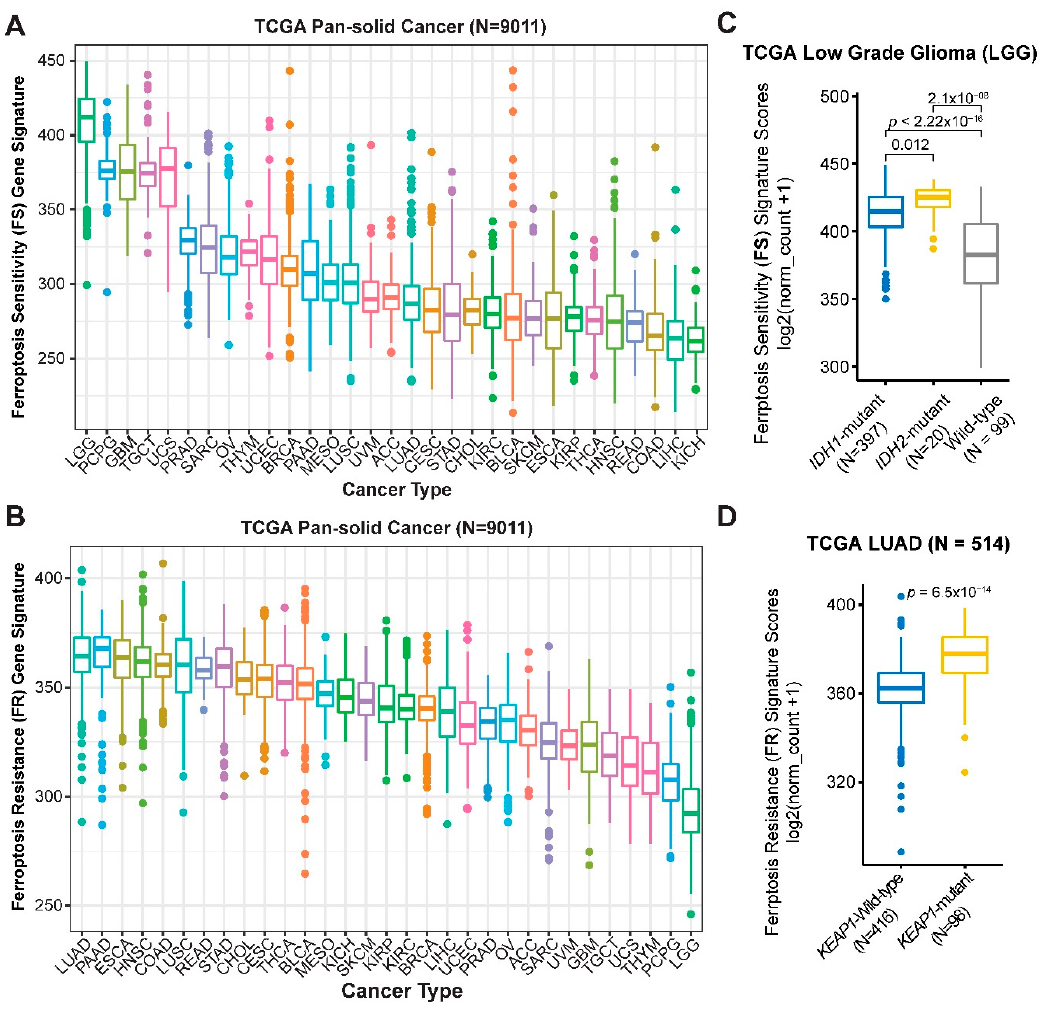
Figure 4. Generalized gene signatures were predictive of ferroptosis sensitivity and resistance. ( A , B ), Prospective analysis of ferroptosis sensitivity (FS) ( A ) and resistance (FR) ( B ) scores in TCGA pan-solid cancer cohort. ( C ), Significant di ff erence (by one-way ANOVA) of the FS gene signature score between IDH1 / 2 -mutant and wild-type LGG (Lower Grade Glioma). ( D ), Significant di ff erence (by one-way ANOVA) of the FR gene signature score between KEAP1 -mutant and wild-type LUAD (Lung Adenocarcinoma).